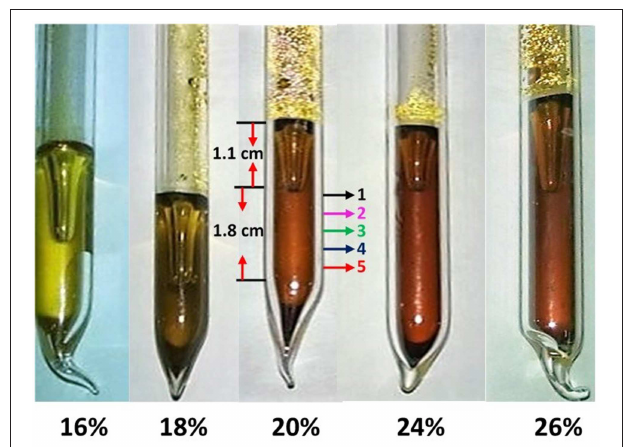
FIGURE 1 | A view of synthesized glasses showing a change of color from a dull yellow at low x (16.0%) transitioning to darker yellow at x = 18%, and to darker orange as x increased to 26.0%. Note that each glass sample displays a meniscus. At x = 20%, we used the 1.8cm long glass column below the meniscus to acquire ex-situ Raman scattering at 5 locations as melts were alloyed. Batch compositions were considered homogeneous when these spectra became